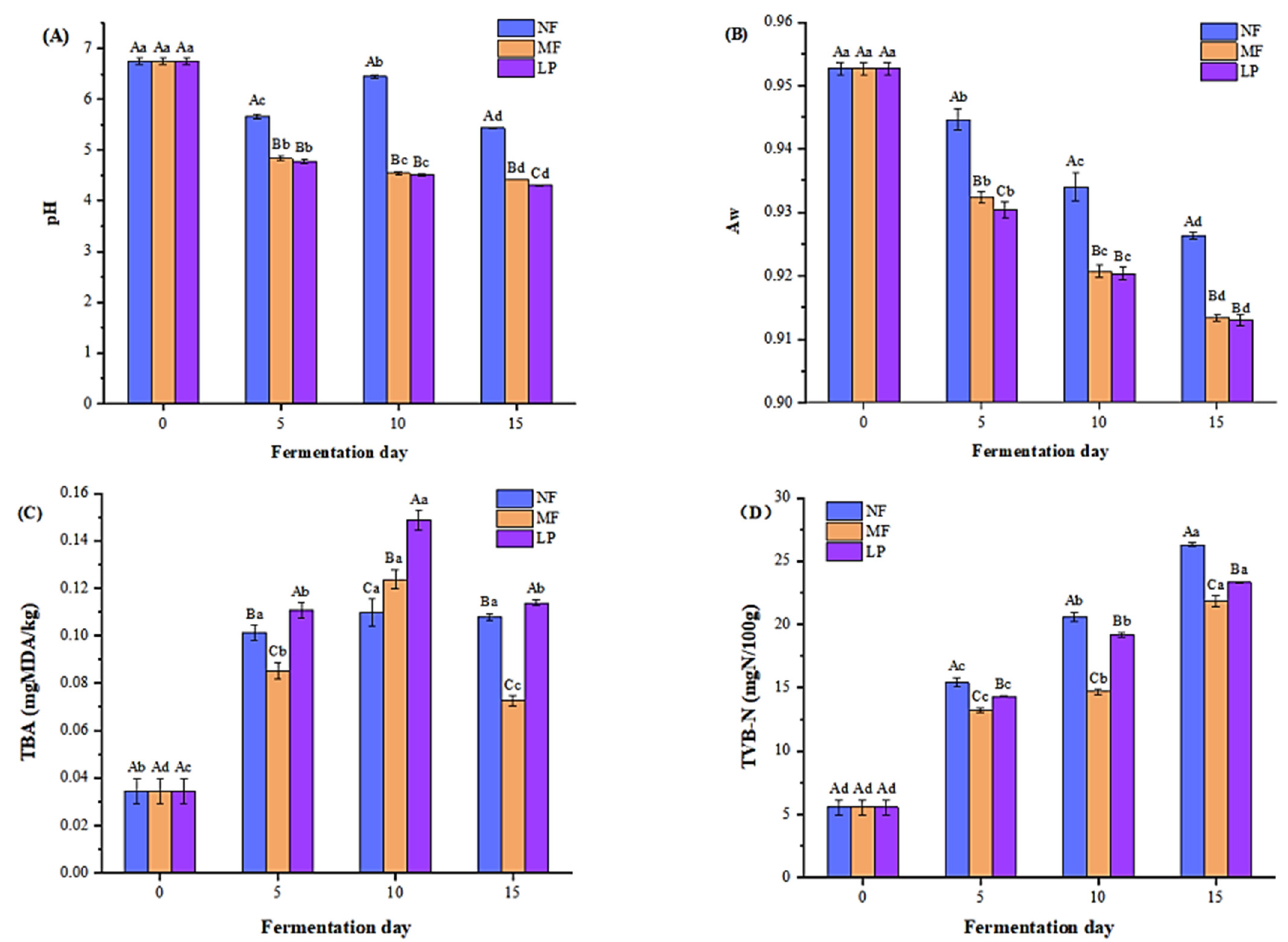
Figure 1. Changes in the pH ( A ), water activity ( B ), thiobarbituric acid reactive substance ( C ), and total volatile base nitrogen ( D ) of Suanyu samples with different fermentation conditions during fermentation. NF, natural fermentation; LP, inoculated L. plantarum ; MF, inoculated L. plantarum combined with S. cerevisiae . Different letters on the bar indicate significant differences ( p < 0.05).